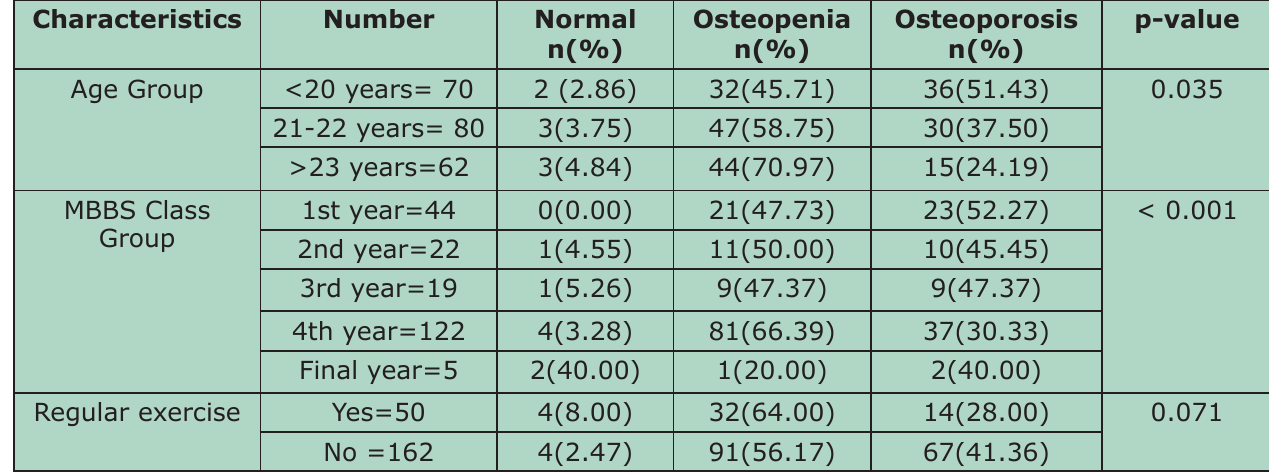
Table-III: Comparison of variables/characteristics among normal, osteopenia and osteoporotic